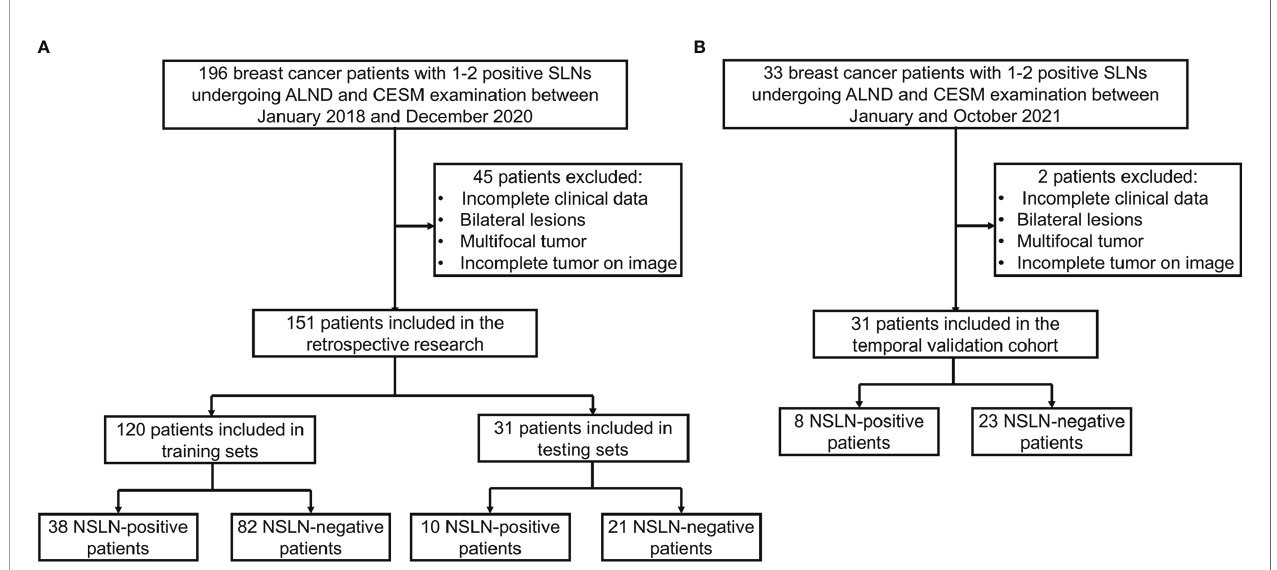
FIGURE 1 | Flow diagram of the study exclusion criteria in the training and testing sets (A) and temporal validation cohort (B) . CESM, contrast-enhanced spectral mammography; SLN, sentinel lymph node; NSLN, non-sentinel lymph node; ALND, axillary lymph node